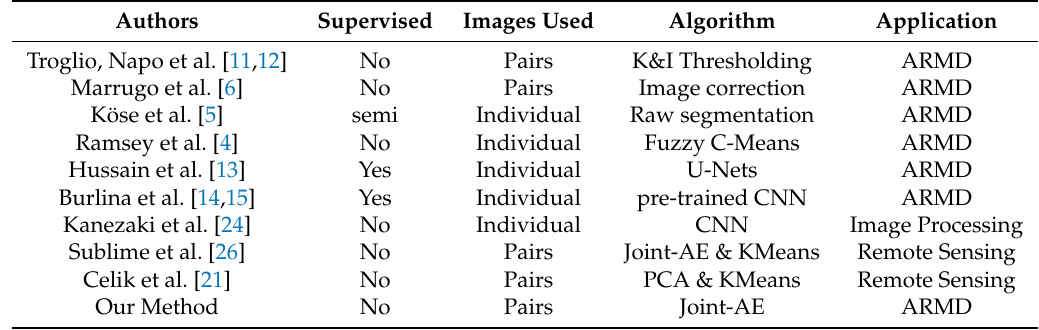
Table 1. Summary of the state-of-the-art methods for change detection that are mentioned in this